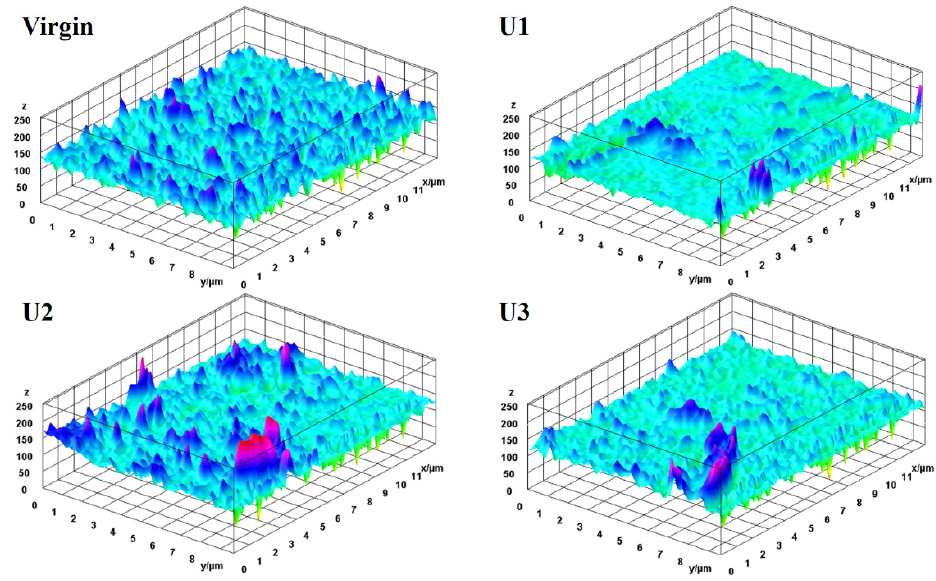
Membranes 2022 , 12 , x FOR PEER REVIEW Figure 8. Topographical images of membranes after operation. Figure 8. Topographical images of membranes after operation.